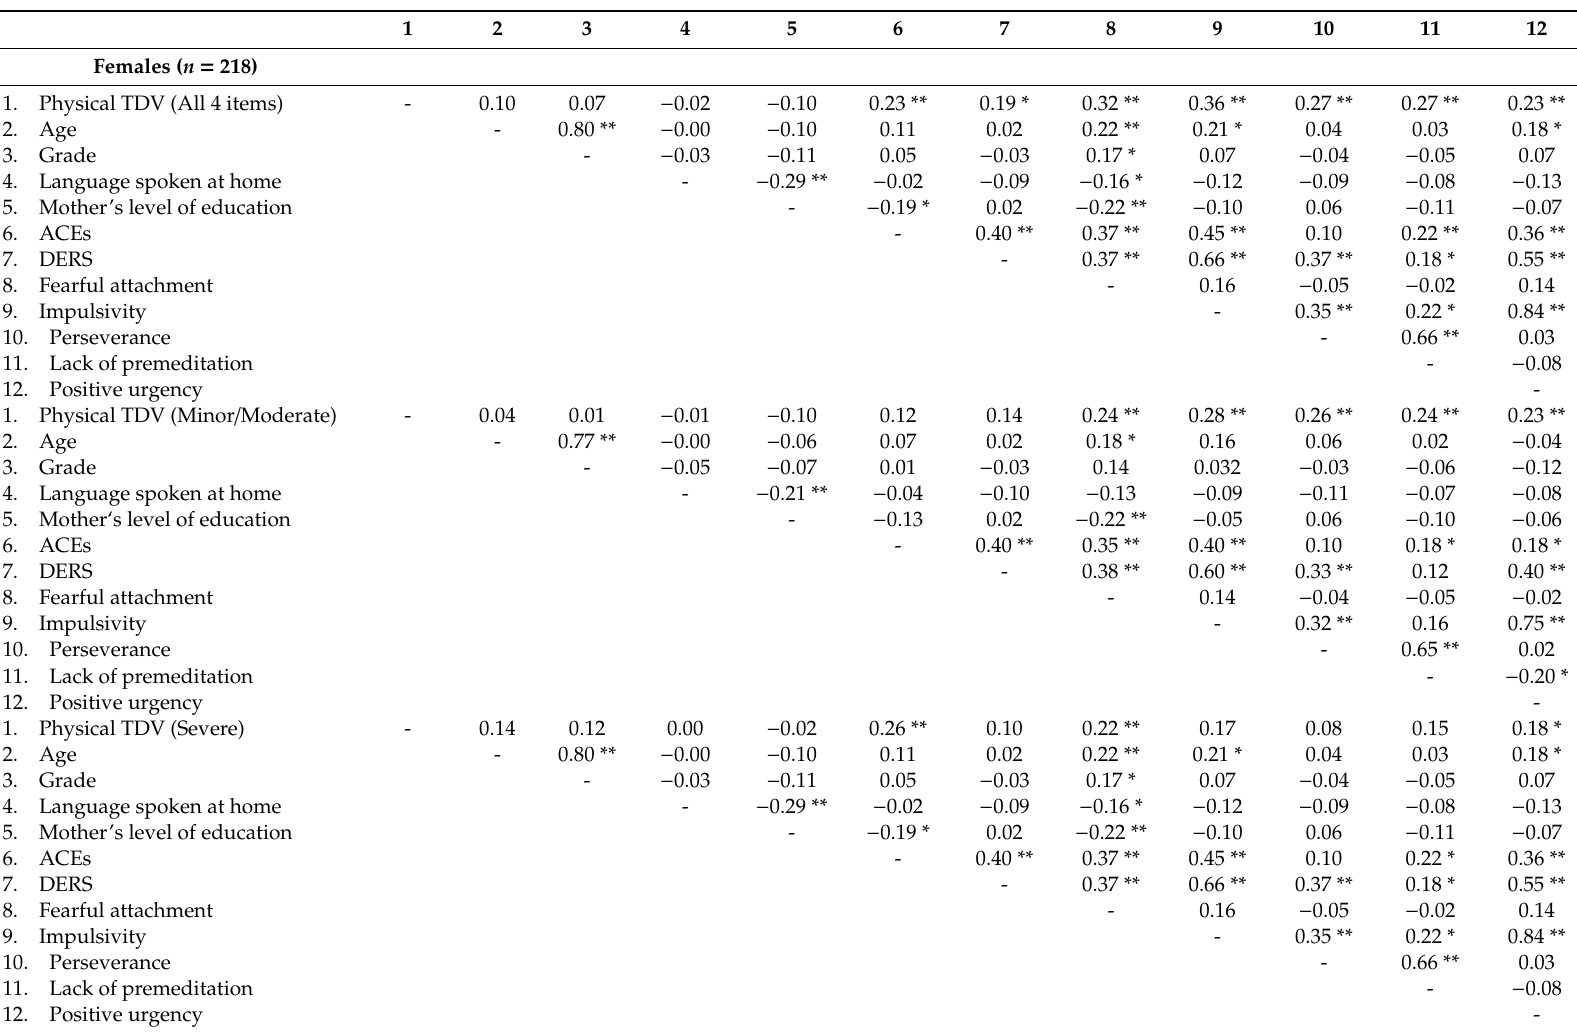
Table 5. Bivariate correlations among study variables for